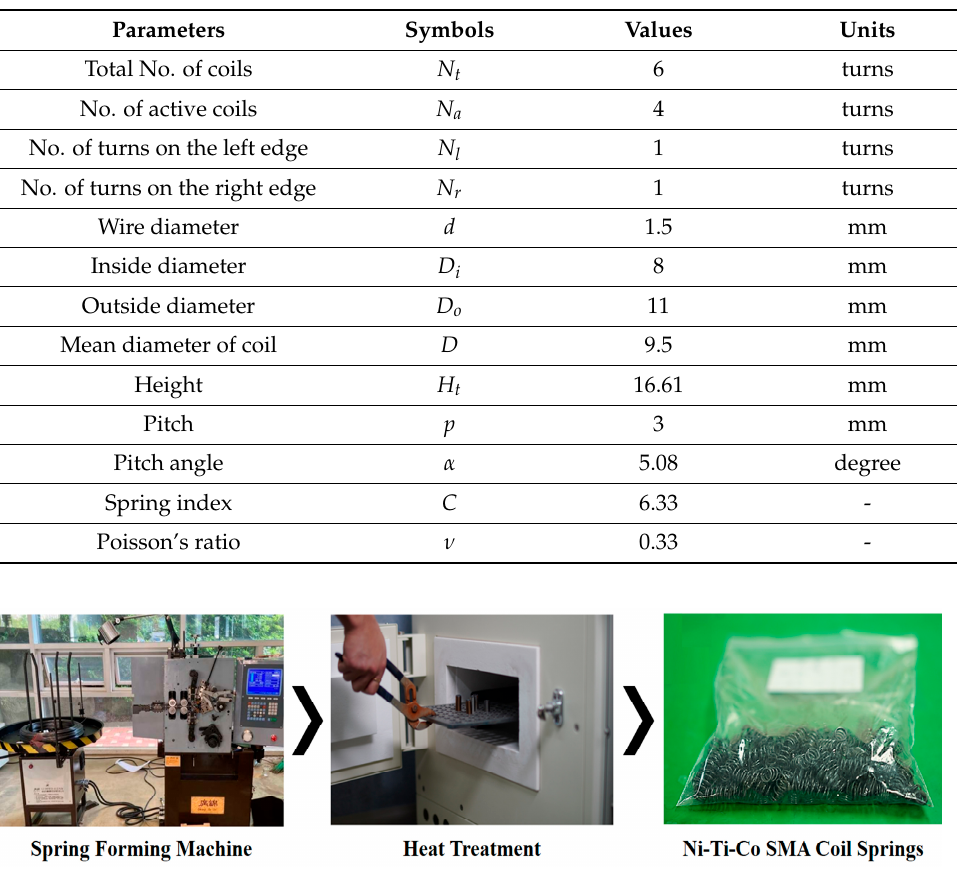
Figure 3. Geometry of SMA coil springs. Table 2. Design parameters of SMA coil springs.